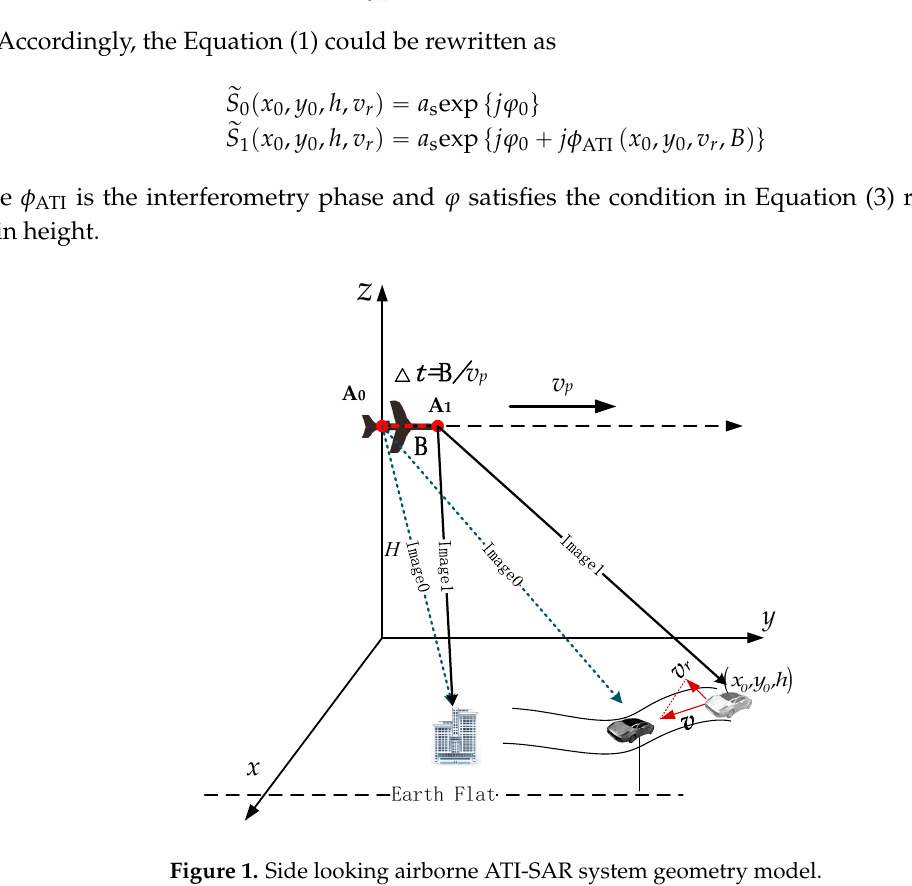
Figure 1. Side looking airborne ATI-SAR system geometry model.